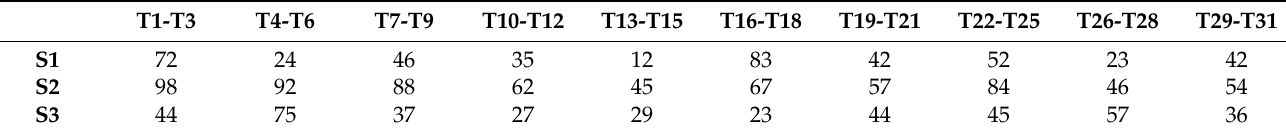
Table 4. Sensor-Task Benefit Matrix.